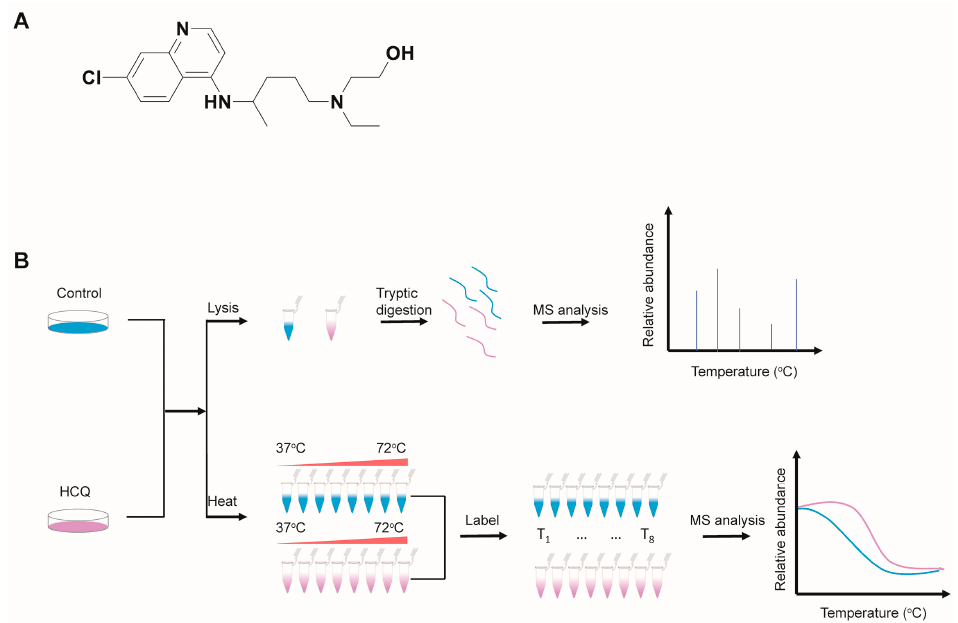
Figure 1. Workflow of the quantitative proteomics and the thermal proteome profiling studies. ( A ) The chemical structure of HCQ. ( B ) Overall workflows of the quantitative proteomics and the thermal proteome profiling. MIA PaCa-2 cells were treated with or without HCQ, respectively. For the quantitative proteomics study, cell lysates were digested with trypsin and analyzed by LC-MS/MS; for the thermal proteome profiling, cells were equally divided into eight aliquots, heated from 37 °C to 72 °C, and the samples were analyzed by LC-MS/MS after TMT labeling.